Question: What visual encoding does this figure use to show its data?
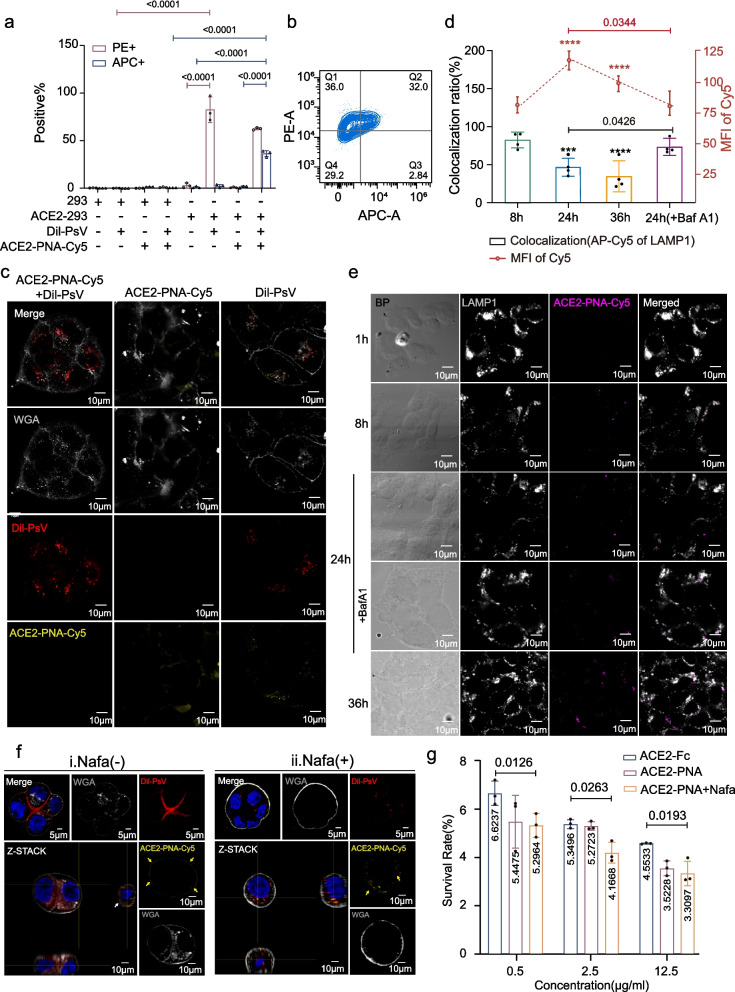
Answer: bar